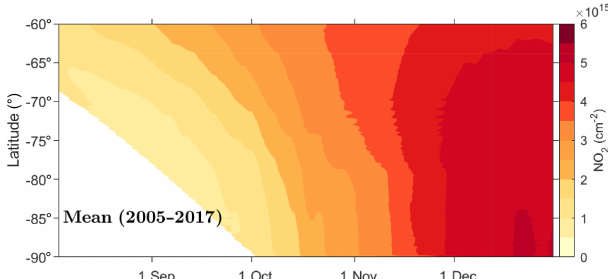
Figure 1. The OMI 3d running mean zonally averaged NO 2 col- umn for the time period from 2005 to 2017. The contour inter- val is 0.5 × 10 15 cm − 2 . The white area at high latitudes in August– September indicates polar night conditions, during which OMI ob- servations are not available.